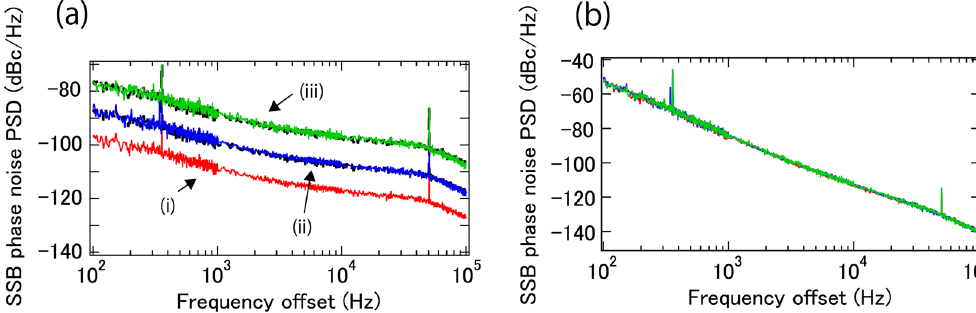
Figure 3. ( a ) SSB phase noise PSD of the mixer output when + / − 1st (i, red), + / − 3rd (ii, blue), and + / − 10th (iii, green) are used. Theoretically expected phase noise for + / − 3rd and + / − 10th from + / − 1st are also shown as dotted black curves. ( b ) SSB phase noise PSD of the DUT estimated from ( a